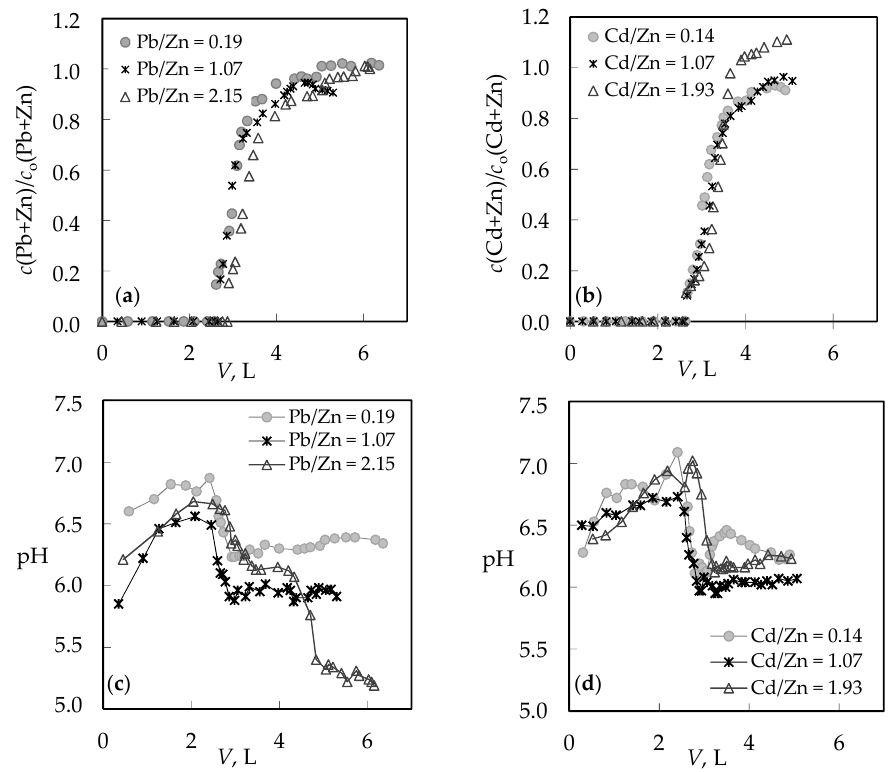
Figure 2 . Breakthrough curves for different Pb/Zn and Cd/Zn concentration ratios expressed as: ( a , b ) the effluent and influent concentration ratios versus volume of the treated solution; ( c , d ) pH changes during service cycles versus volume of the treated solution.